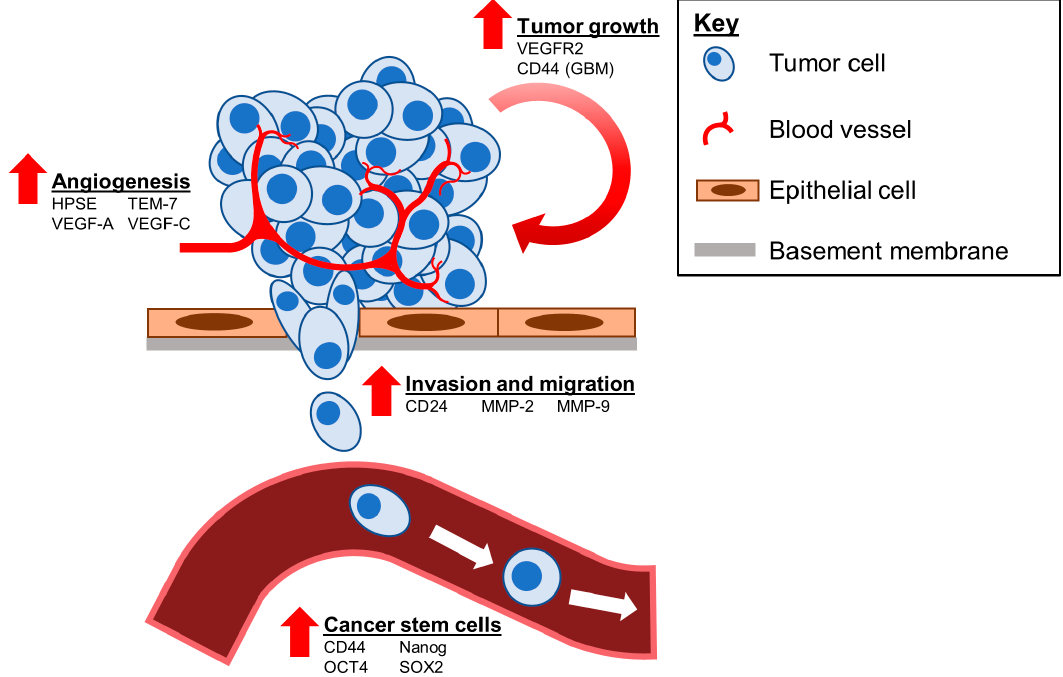
Figure 3. tGLI1-mediated oncogenic phenotypes in glioblastoma and breast cancer. In addition to regulating several known GLI1 target genes, tGLI1 gains the ability to modulate several potent oncogenic phenotypes via transcriptional activation of genes not regulated by GLI1: (1) angiogenesis via HPSE, TEM-7, VEGF-A, and VEGF-C; (2) tumor growth rate by increasing VEGFR2 and CD44 (GBM only) expression; (3) invasion and migration via CD24, MMP-2 (BrCa only), and MMP-9 (BrCa only); and (4) cancer stemness via upregulation of CD44, Nanog, OCT4, and SOX2. BrCa, breast cancer; GBM, glioblastoma.